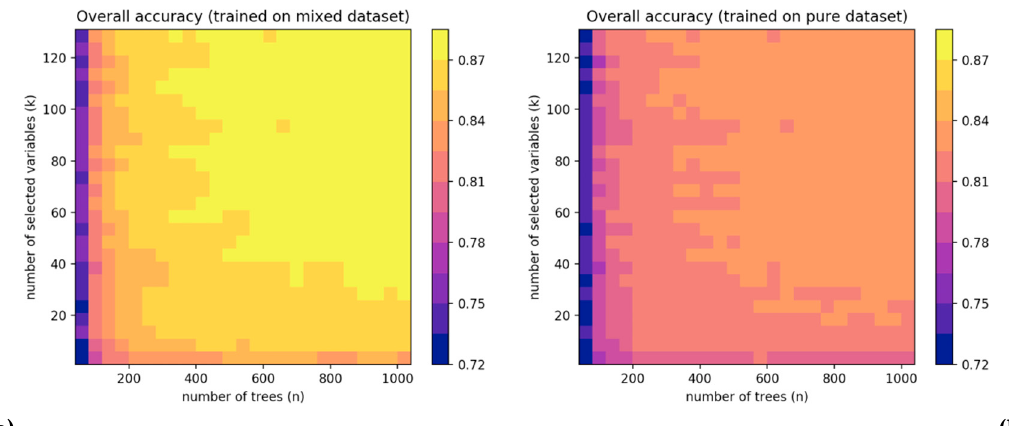
Figure 6. Fine-tuning of the parameters n and k of the random forest (RF) model, ( a ) the overall accuracy of the RF trained on pure-mixed pixel set , ( b ) the overall accuracy of the RF trained on Pure pixel set . When n equals 500 and k equals 40, the performances of RF models converge; thus, we selected this combination for further experiments.